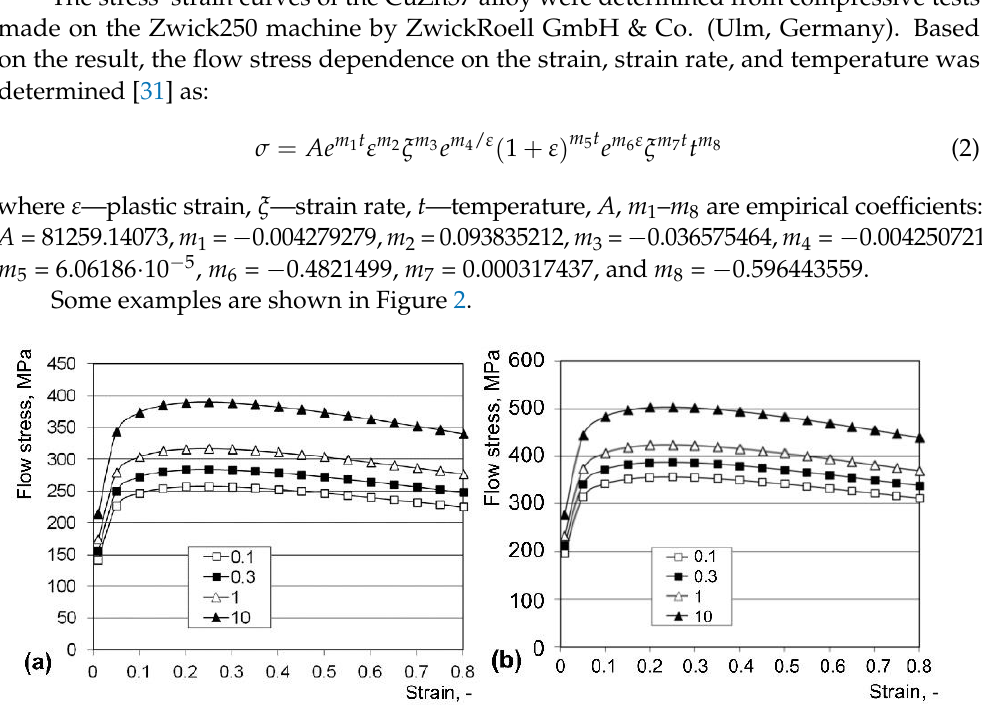
Figure 2. Stress – strain curves of CuZn37 alloy for 400 °C ( a ), 350 °C ( b ), and different strain rates Figure 2. Stress–strain curves of CuZn37 alloy for 400 ◦ C ( a ), 350 ◦ C ( b ), and different strain (0.1 – 10 s − 1 ). rates (0.1–10 s − 1